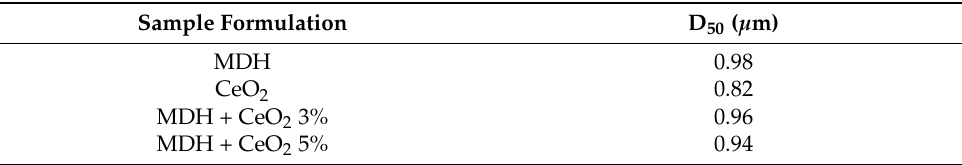
Table 3. PSA Results of the Pure and Modified Fillers.